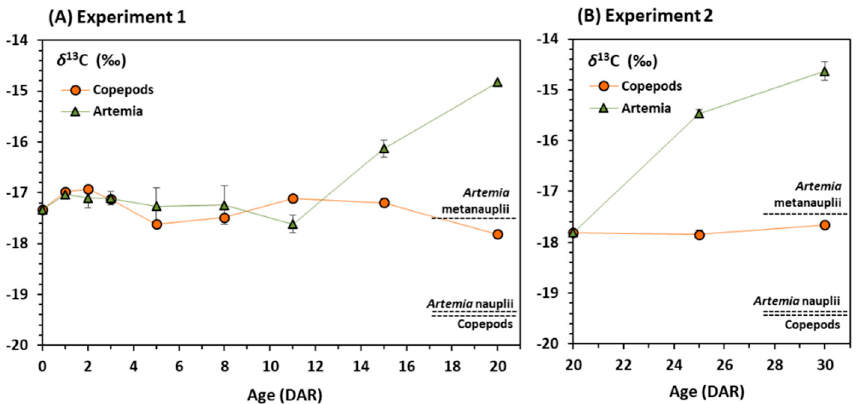
Figure 3. Changes in δ 13 C values in juvenile seahorses Hippocampus guttulatus fed on copepods or Artemia over each experimental period. ( A )—Experiment 1: Juveniles fed on Artemia (nauplii and metanauplii) or copepods until 20 DAR; ( B )—Experiment 2: Juveniles fed on copepods in Experiment 1 until 20 DAR and subsequently fed on Artemia (nauplii and metanauplii) or copepods until 30 DAR. Horizontal dotted lines represent the isotopic composition of prey (copepods and Artemia nauplii and metanauplii). Means and standard deviations are represented.